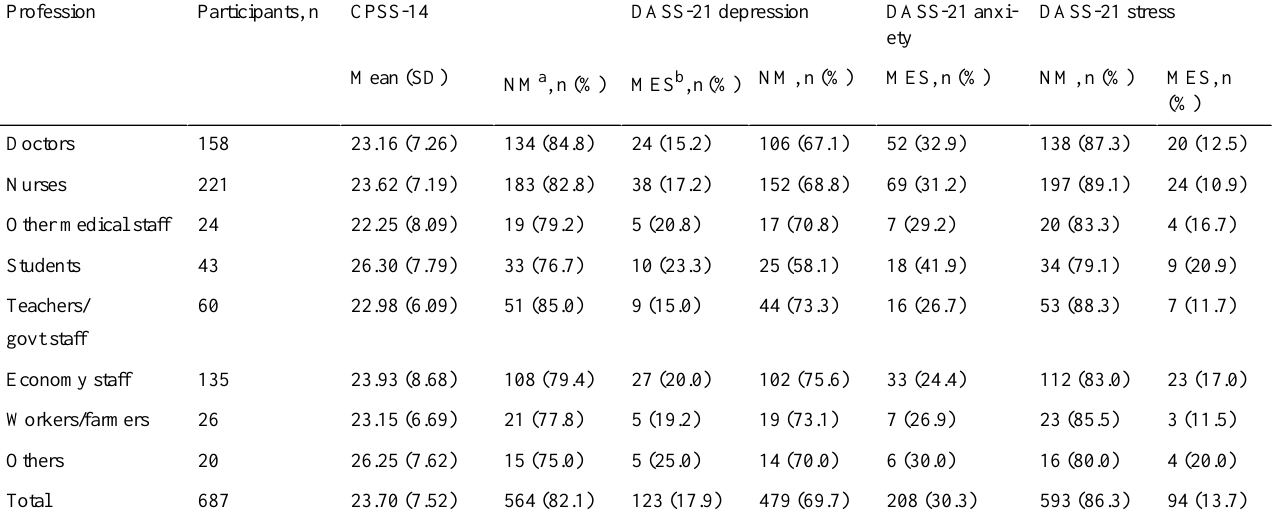
Table 2. Results of the Simplified Chinese version of the 14-item Perceived Stress Scale (CPSS-14) and the Depression, Anxiety and Stress Scale - 21 Items